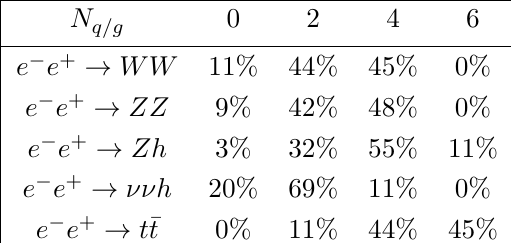
Table 1 . Branching ratios of hadronic modes, for the primary Higgs and electroweak processes p in low- s runs of future e (cid:0) e + colliders. Here N (anti-)quarks and gluons in their (cid:12)nal states. (cid:28) decays are de(cid:12)ned to be leptonic. W=Z decays are assumed to be two-body